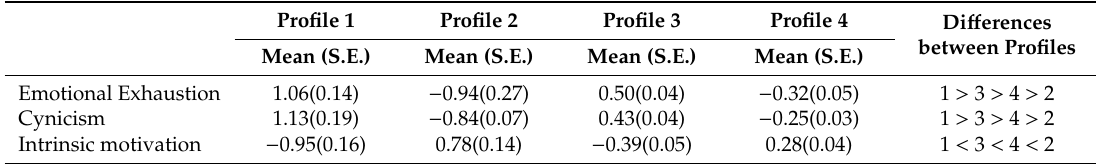
Table 4. Outcome means and pairwise comparisons between